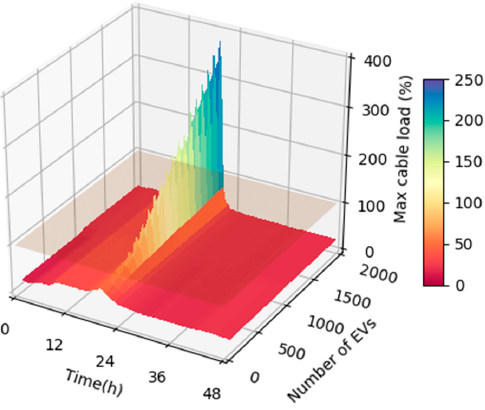
Figure 11. The maximum cable loading in Scenario 3 in the upper feeder for different numbers of EVs.